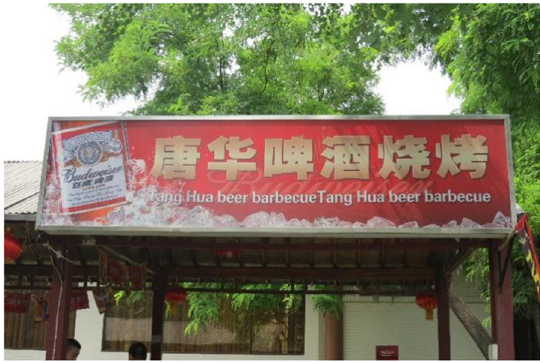
Fig. 3 The Tang Hua beer and barbecue stall on the grounds of the Xi’an Garden hotel, 2013 (Source: the